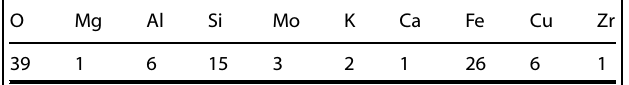
Presence of Cu is only due to the support grid of the FIB